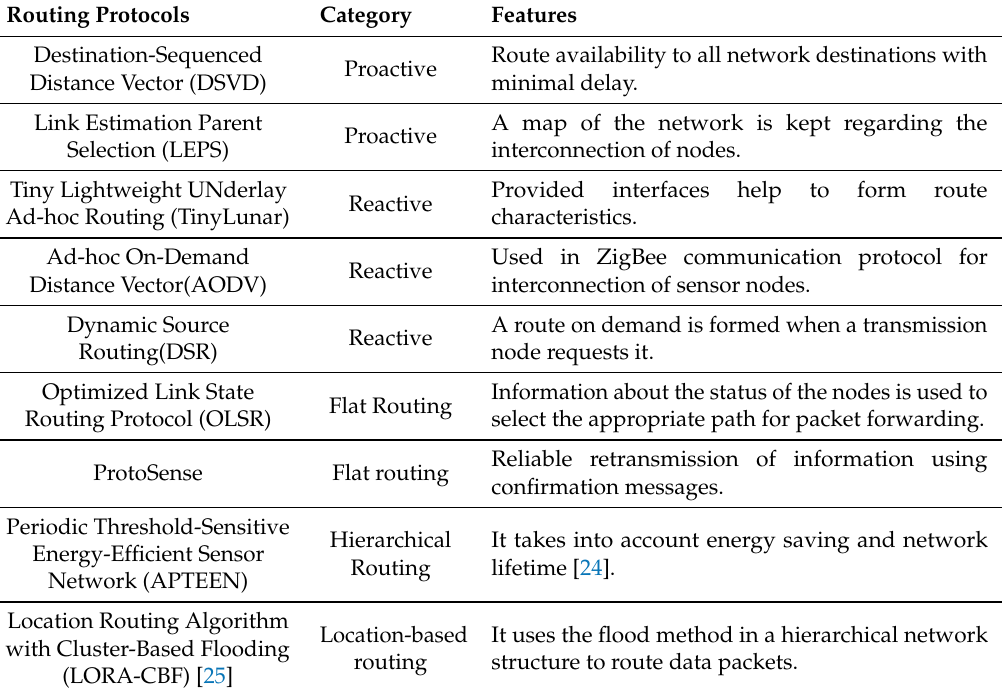
Table 4. Smart farming routing